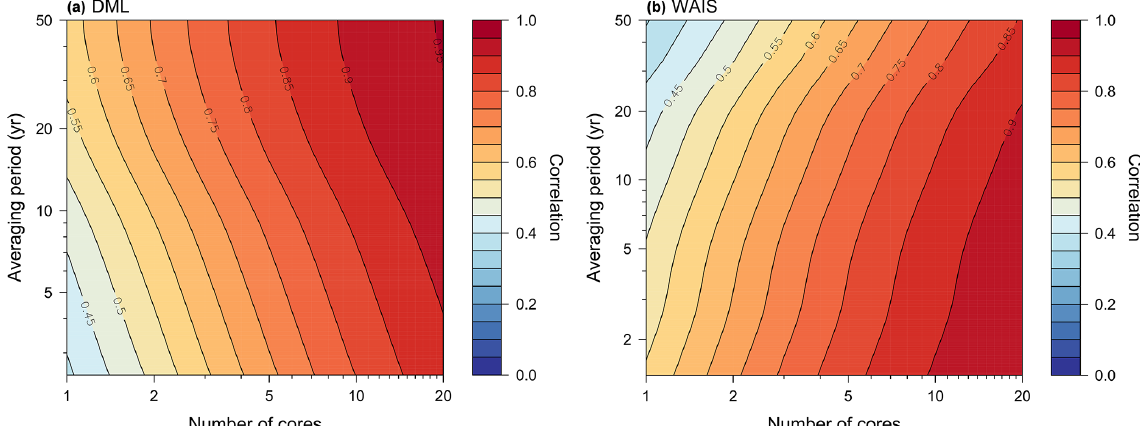
Figure 4. Estimated correlation of stacked isotope records from (a) DML and (b) WAIS with their common signal as a function of the averaging period and the number of firn cores included in the average. The correlations are based on Eq. (7) with the same signal and noise spectra that were used for Fig.